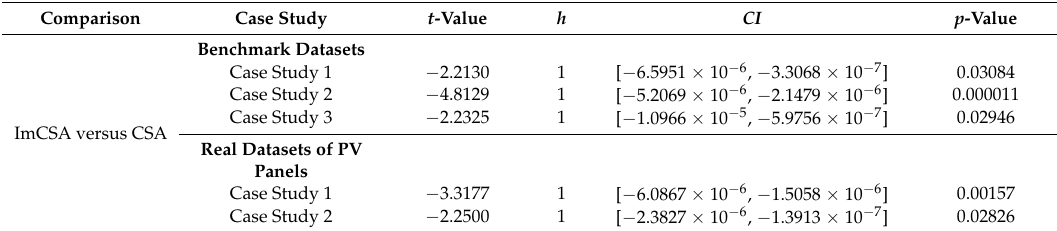
Table 16. Results of the t test on the data in Tables 1, 4, 7, 10 and 13. Comparison